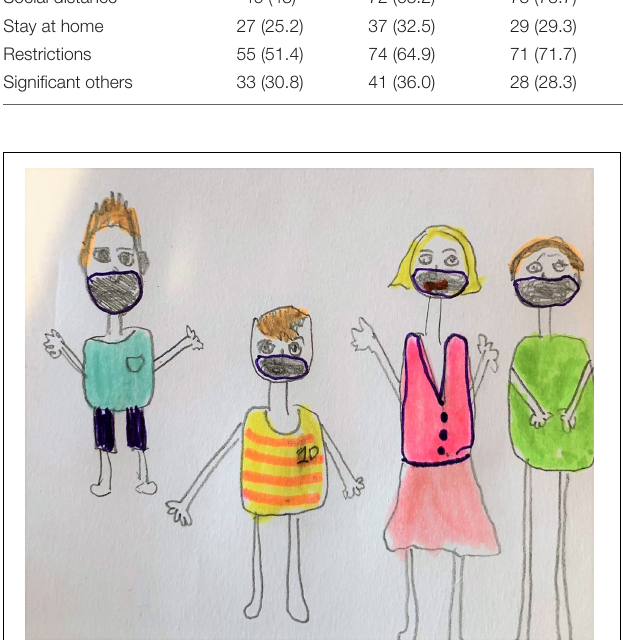
FIGURE 5 | A 6-year-old boy’s drawing of his family members wearing